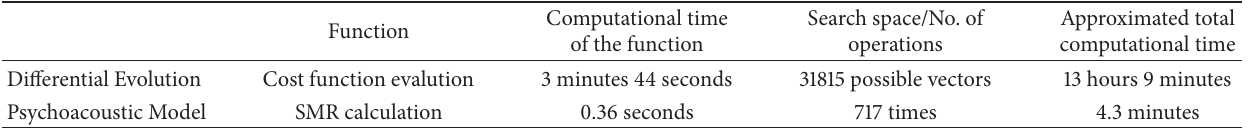
Table 8: Comparison of the computational times for determining the parameters of an host signal when the automatic parameterization is based on the differential evolution [29] and when it is based on the psychoacoustic model. The simulations were operated on the Fujitsu CX250 Cluster (JAIST parallel computers), where each node is equipped with Two Intel Xeon E5-2680v2 2.80 GHz (10 cores each) and 64 GB memory.